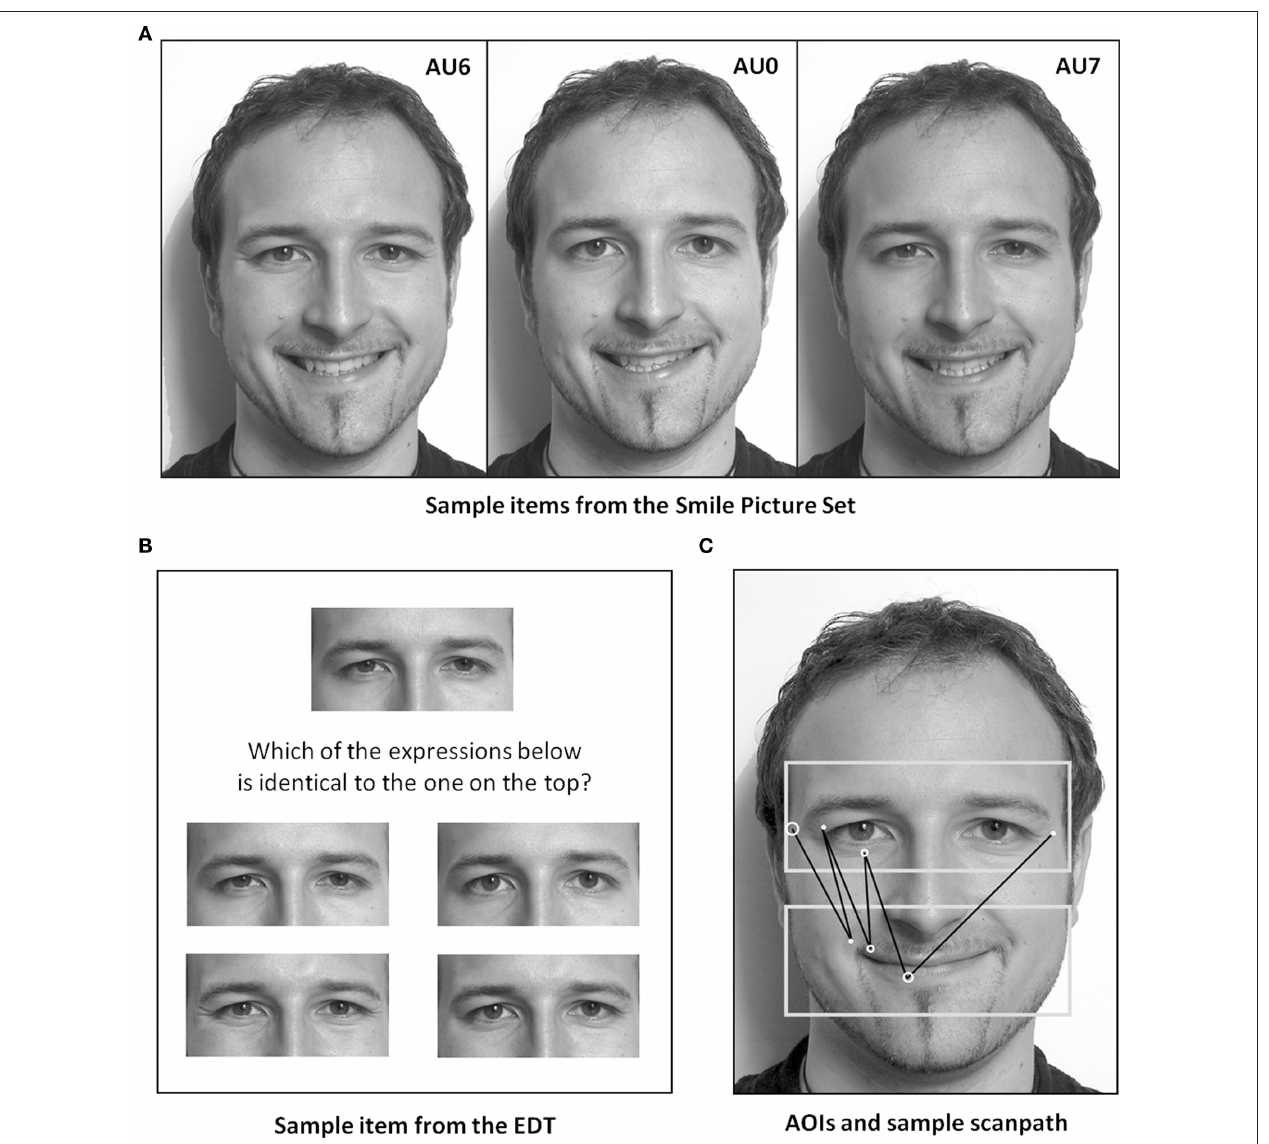
scanpath in response to a Duchenne smile picture (AU6 + AU12). Light gray boxes indicate Areas of Interests (AOIs); circle size indicates fixation duration. (C) Sample item from the Eyes Discrimination Task. To prevent discrimination based on chromatic cues, the figure of the top was shown in color, while the four response alternatives were displayed in black and